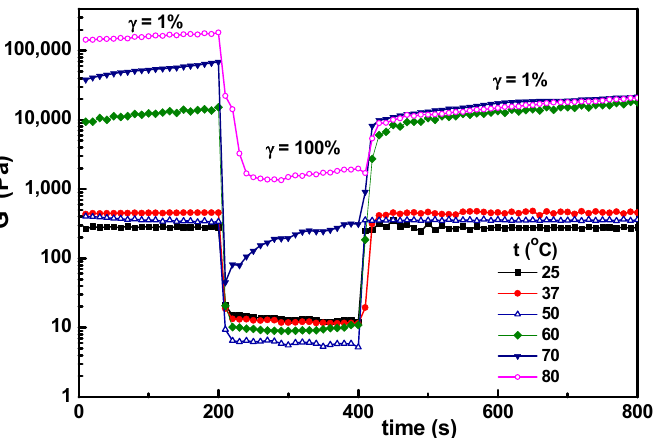
Figure 9. Temperature influence on the self-healing behavior of hybrid hydrogels for the sample with w BSA = 0.5 submitted to successive step strains of 1%–100%–1%.